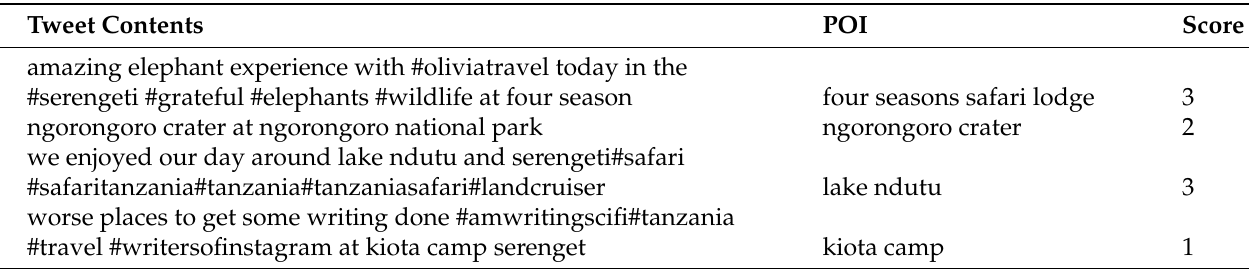
Table 9. Examples of star-rated annotated tweets.